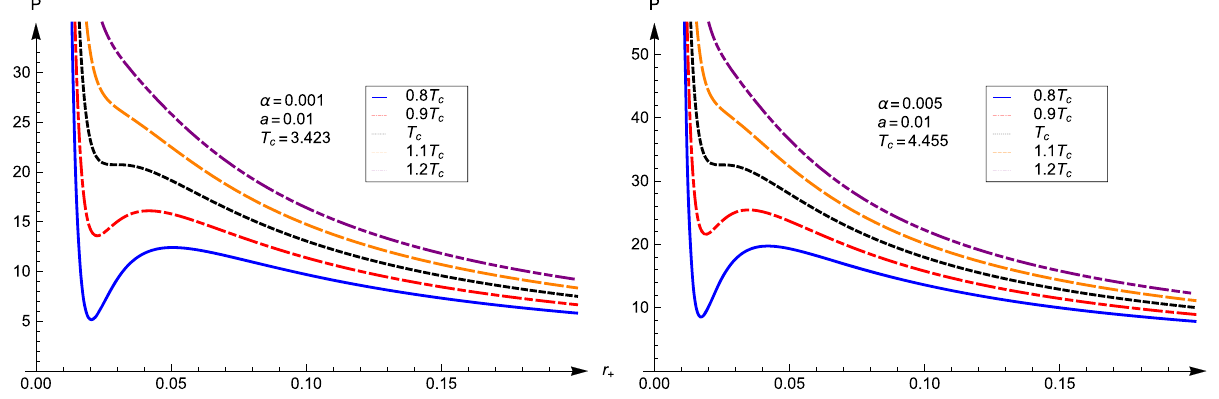
Fig. 2 Pressure versus r + for a = 0 . 01 and α = 0 . 001 (left panel), and α = 0 . 005 (right panel)